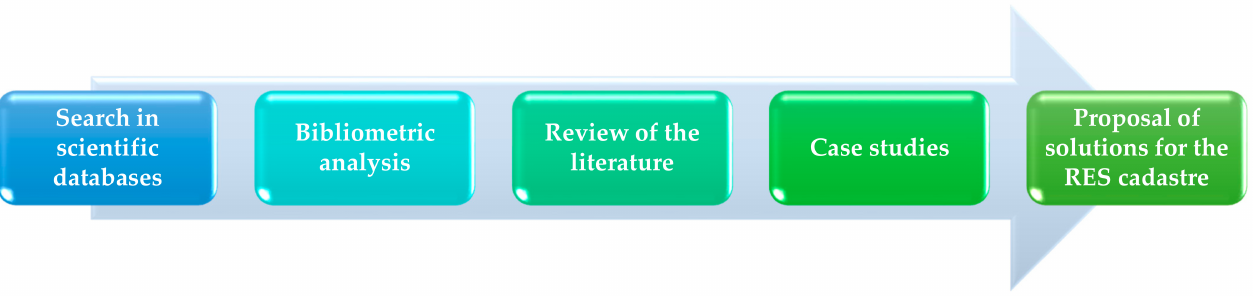
Figure 1. Scheme of the research methodology. Source: own